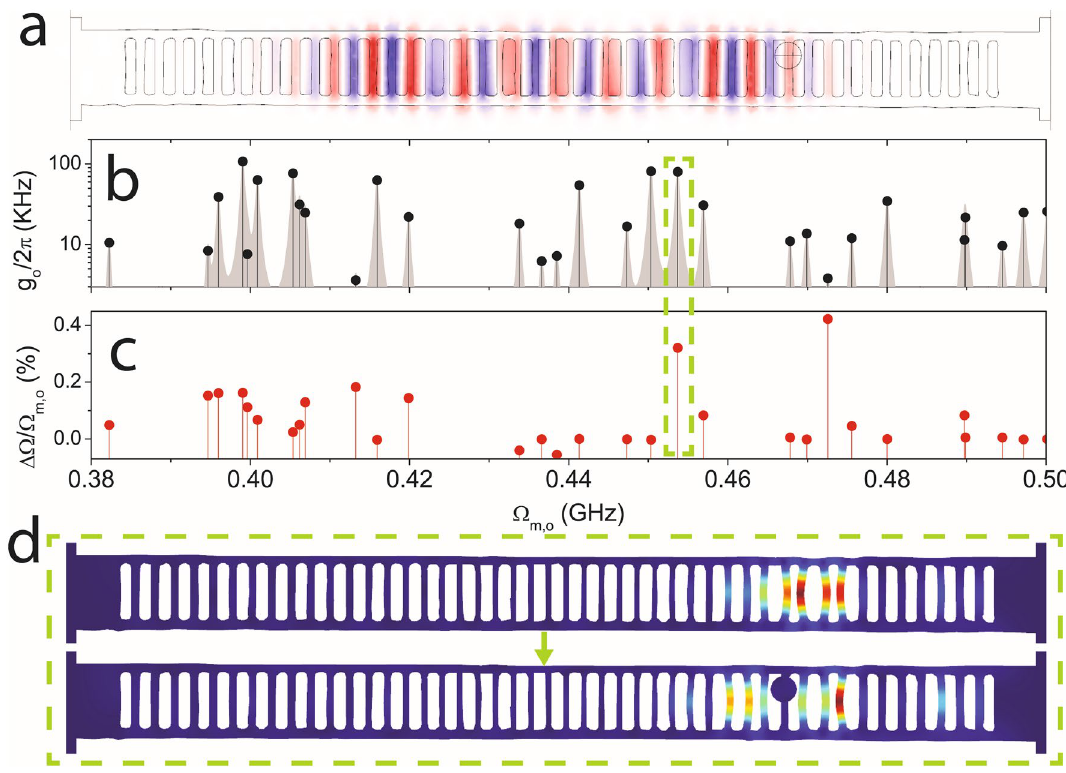
Figure 2. Finite-Element-Method simulations of the fabricated OMC with and without a submicrometric particle. ( a ) Spatial profile of the simulated optical mode employed for the evaluation of the single- particle optomechanical coupling rates (g o /2π). ( b ) Computed g o /2π covering the frequency range of the pinch mechanical modes family. ( c ) Relative frequency shift of the mechanical modes with respect to the eigenfrequencies displayed by the OMC without particles. The dashed green box highlights the case of the mechanical modes visualized on panel ( d ). The geometry has been imported from the SEM micrograph of the fabricated